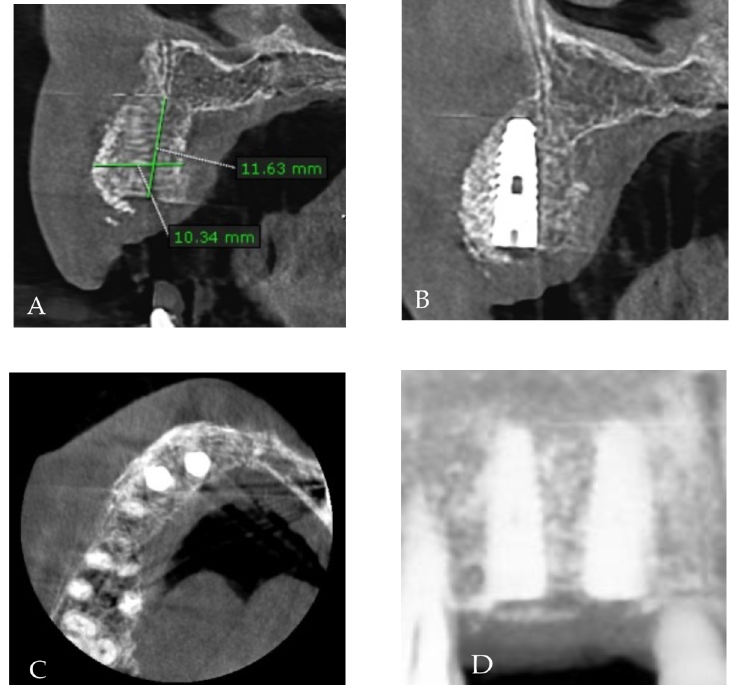
Figure 11. Cone-beam CT images of the implants position in the augmented bone ( A ), ( B ) sagittal view, ( C ) axial view, and ( D ) coronal view.